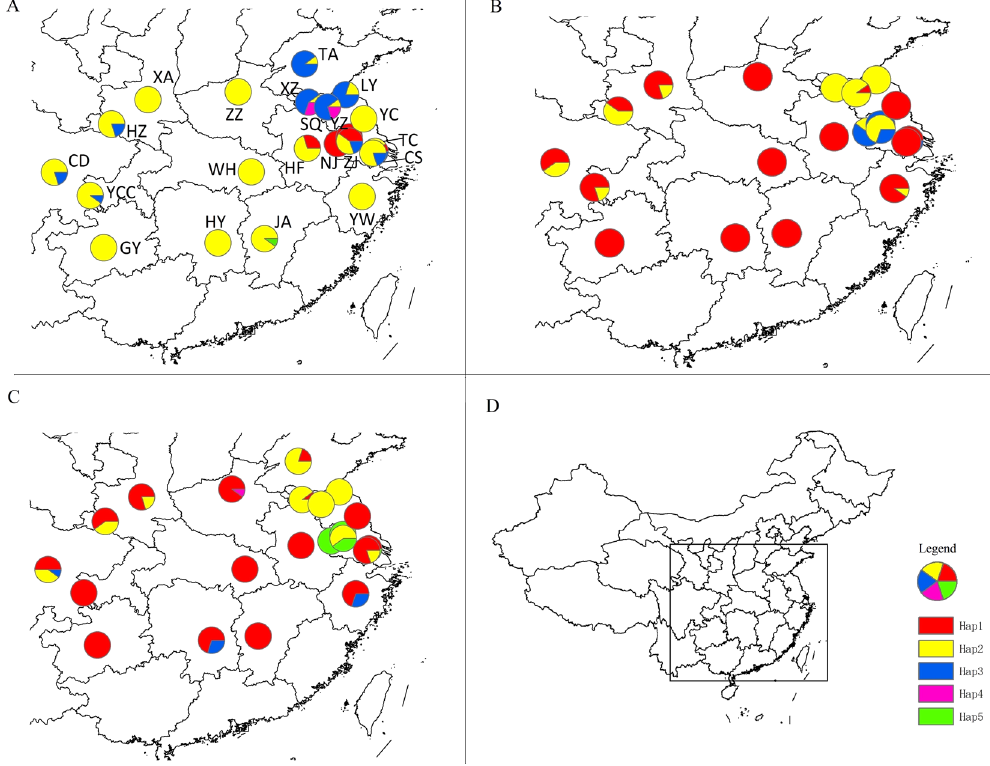
Figure 1. Collection sites in China and haplotype distribution in each population. ( A , B and C ) represent COI , ND1 and ND5 , respectively; ( D ) national map and legend. The map is made by ArcGIS 10.2 software, http://